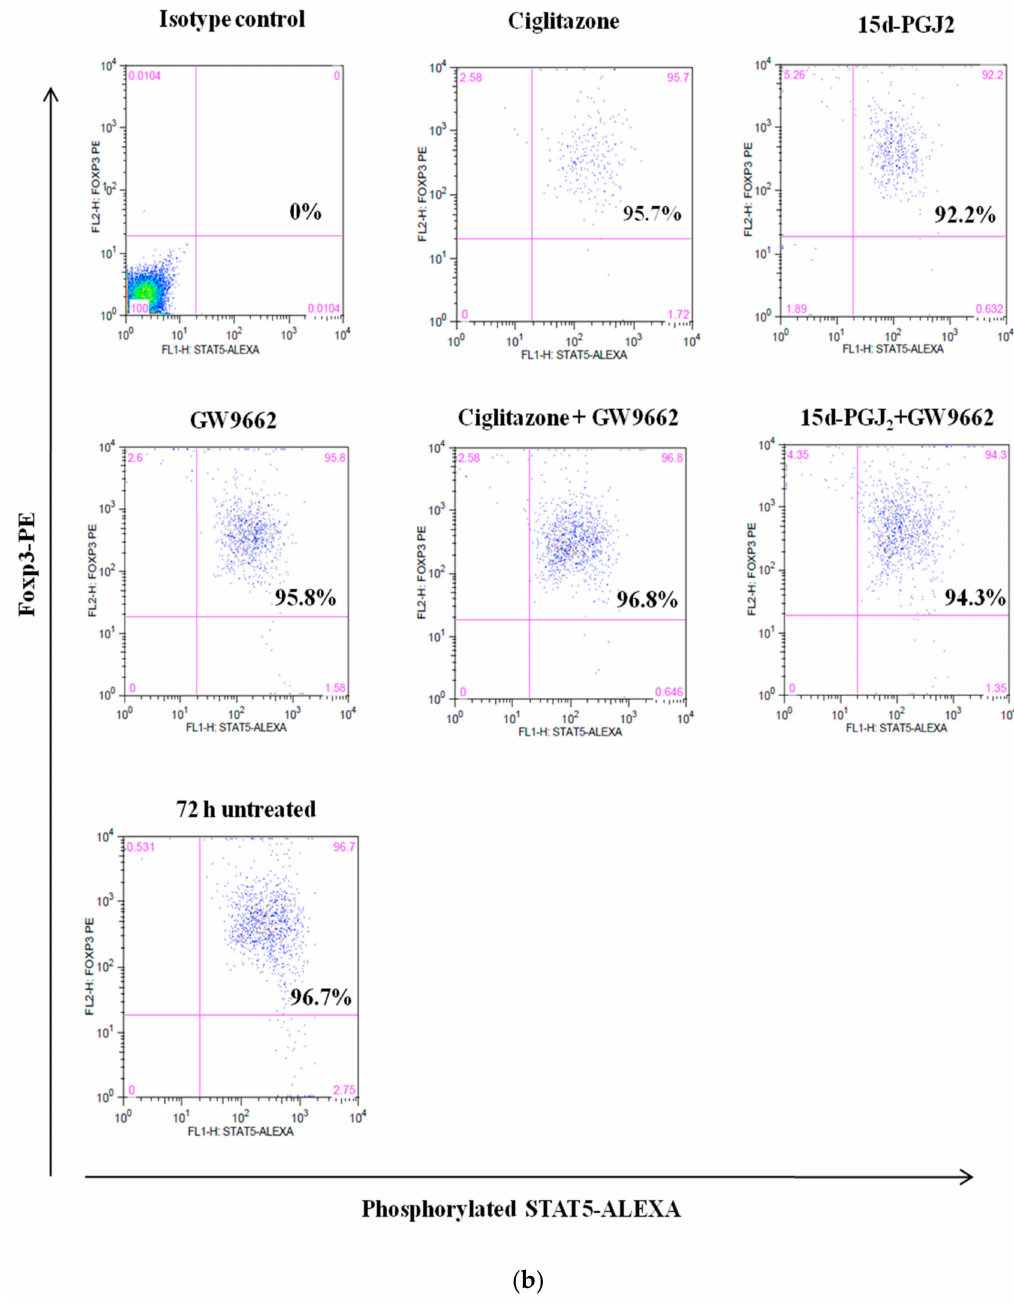
Figure 5. The expression of phosphorylated STAT-5 in activated nTreg cells of ( a ) NOD and ( b ) NOR mice following various treatment after 72 h culture. Dot plot shows the levels of phosphorylated STAT-5 in nTreg cells. STAT-5 phosphorylation level was measured in activated nTreg cells treated with ciglitazone, 15d-PGJ 2 , GW9662, combination of ciglitazone + GW9662, and combination of 15d-PGJ 2 + GW9662. 72 h-untreated group was assigned as control group. Data shown are representative of two independent experiments ( n = 2